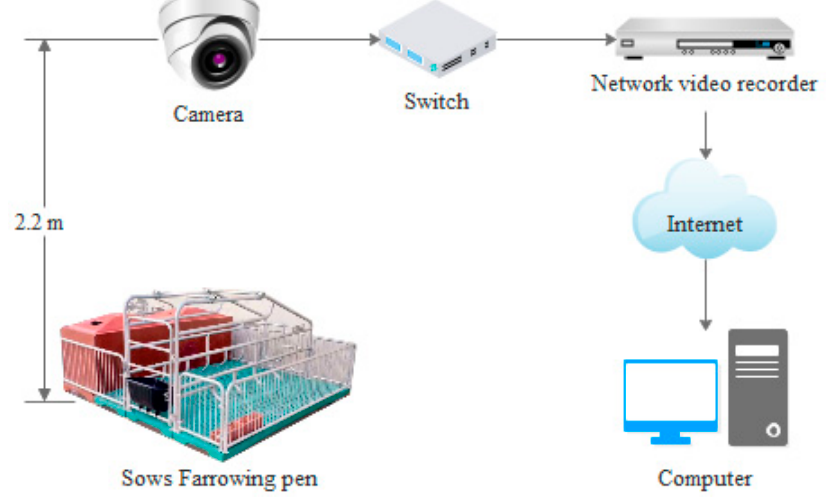
Figure 1. Sketch of video acquisition.